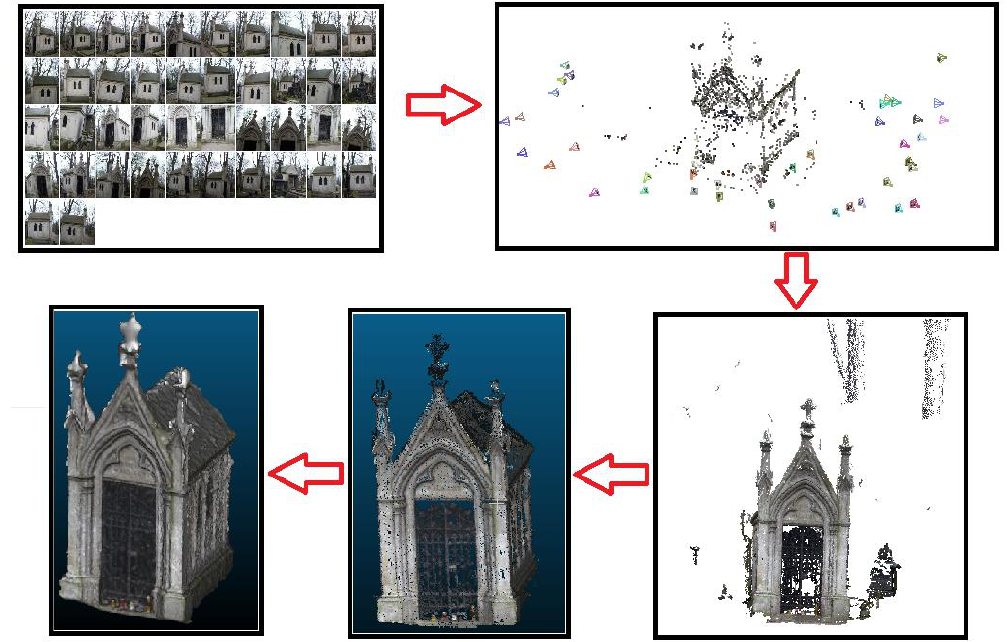
Figure 2. The process of generating texture of 3D model: 1. taking images, 2. sparse reconstructing, 3. dense reconstructing, 4. filtering and scaling, 5. surface reconstructing and texturing